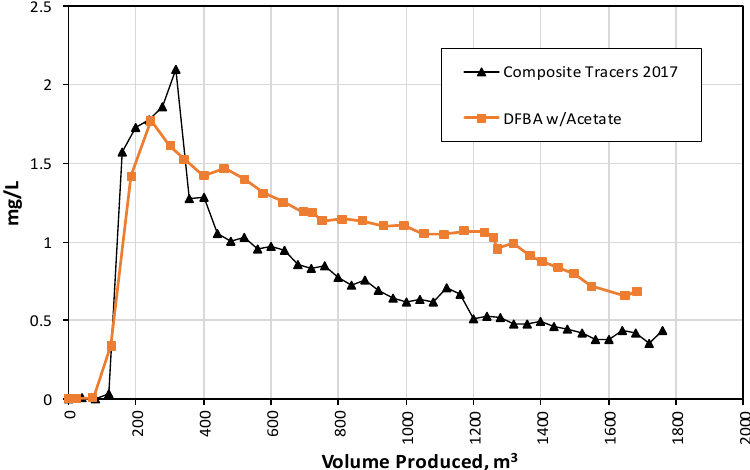
Figure A21. Breakthrough curves of tracers in well 4P-206 in fall 2017 and of difluorobenzoate after the acetate addition. Note that fall 2017 tracer concentrations are the sum of the 4 tracers arriving in 4P-206 divided by 6 (the number of injection wells used in the acetate test). The higher tail of the DFBA w/acetate curve is attributed to the recirculation of the tracer in the amendment test, whereas the tracers were diverted to a surface facility and not recirculated in the 2017 tracer test.